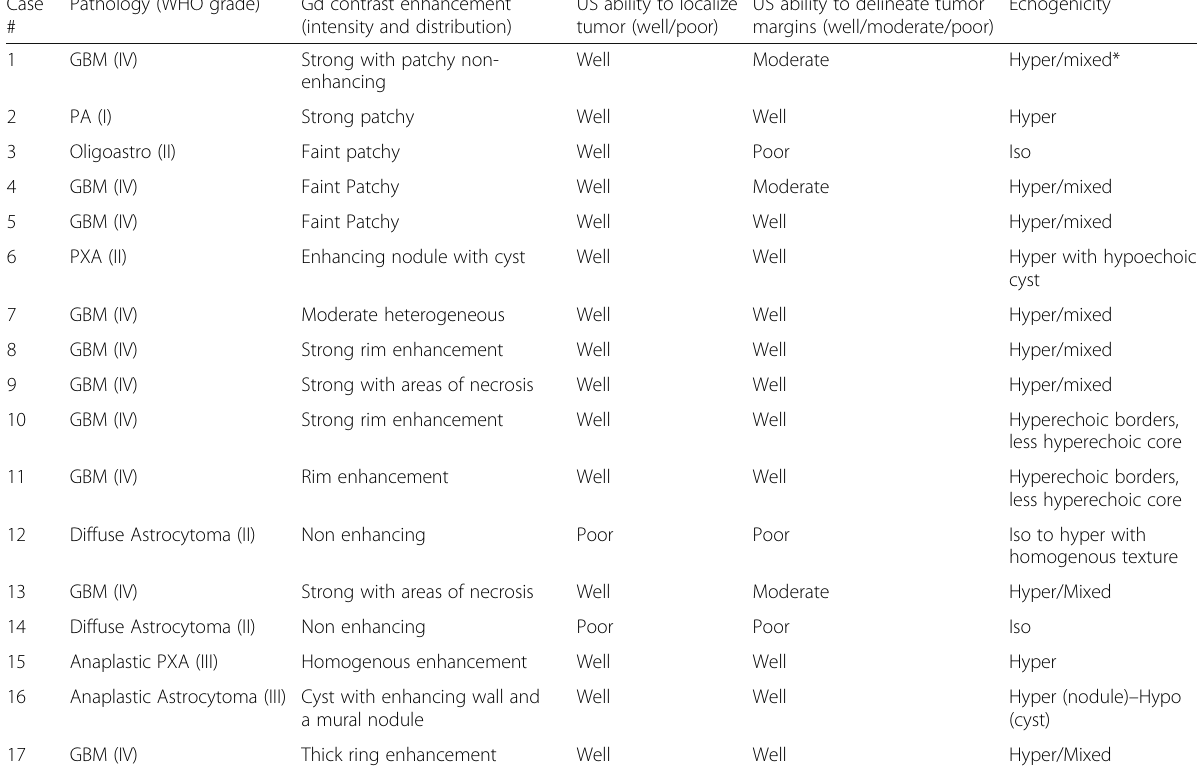
Table 5 Sonographic appearance of intracranial